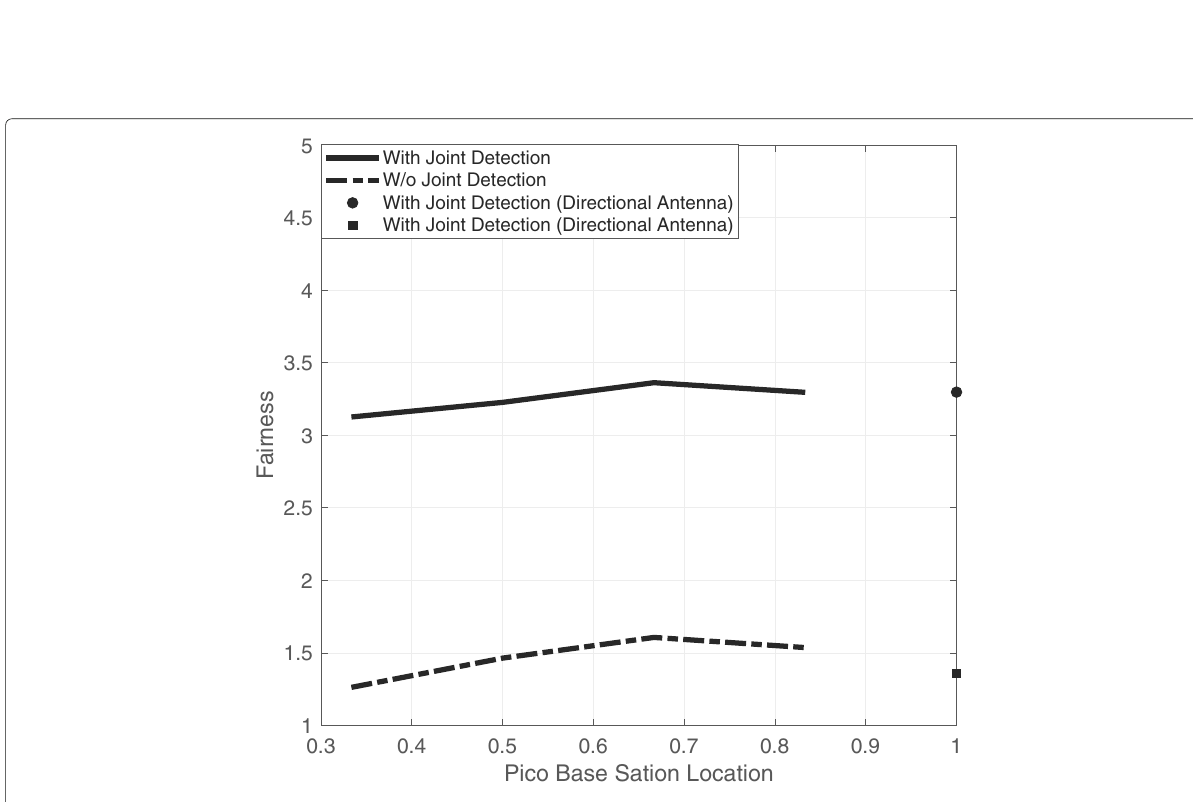
Fig. 8 User fairness versus PBS location (10